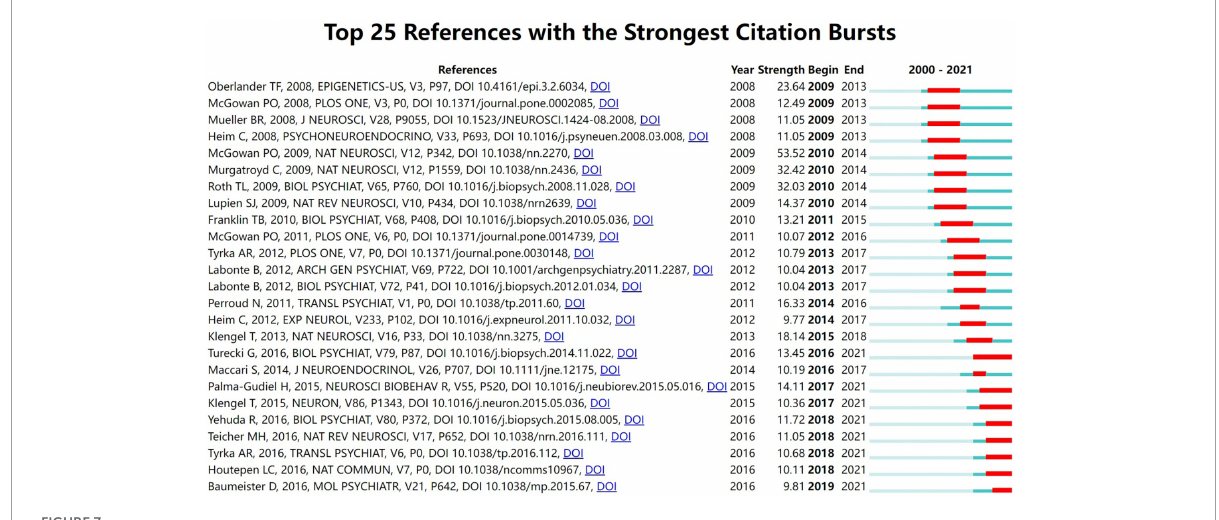
FIGURE7 Top 25 reference with the strongest citation burst in childhood trauma-epigenetics